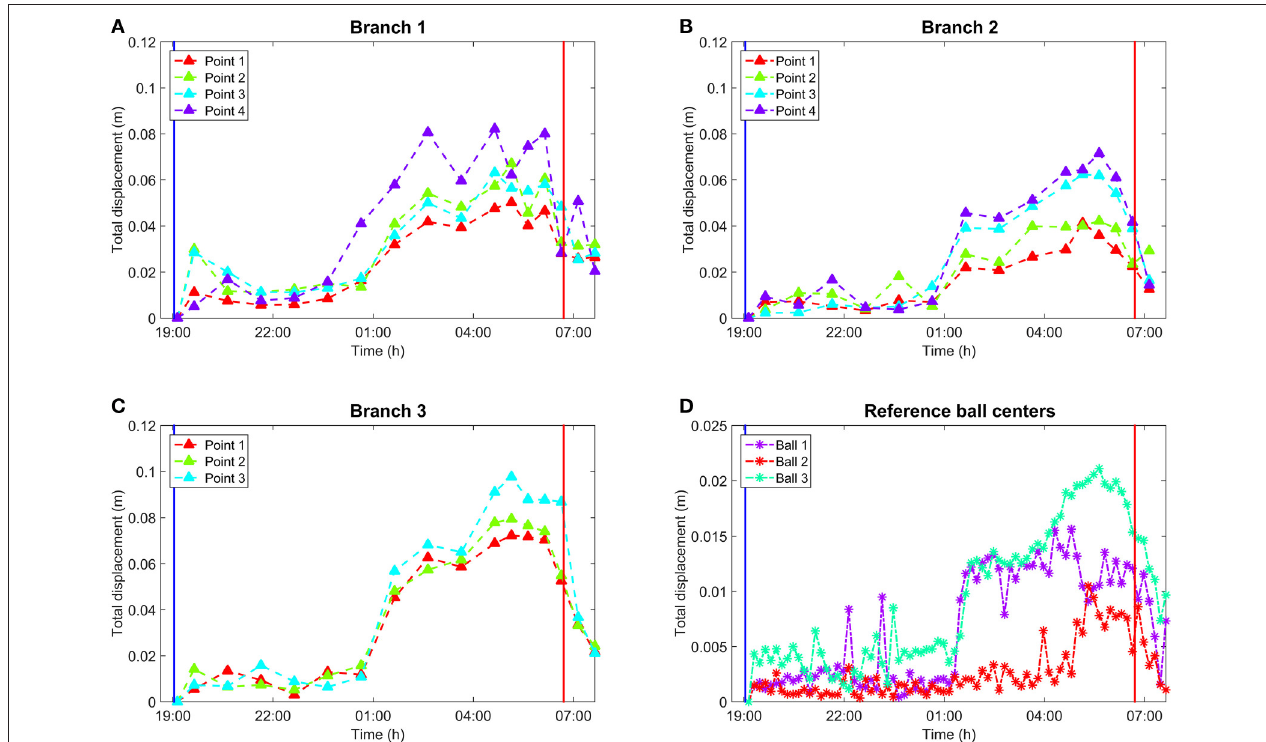
FIGURE 5 | (A) Total movements of the representative points on Branch 1 over time. (B) Total movements of the representative points on Branch 2 over time. Branch 2 is missing the last epoch due to internal occlusion. (C) Total movements of the representative points on Branch 3 over time. (D) Total movement of reference target centers over time. Vertical lines in all subplots mark sunset and sunrise. All values in (A–D) represent the absolute 3D movement compared to the initial point selection at the scan closest to sunset. Manual point selection in (A–C) was performed by picking scans once per hour which was sufficient to represent the general movement trend over time. In (D) , reference centers were extracted automatically for all 77 scans. The reference spheres were attached on thicker branches and closer to the stem than Branches 1–3. This resulted in smaller movement amplitudes in the sphere center movement than with the